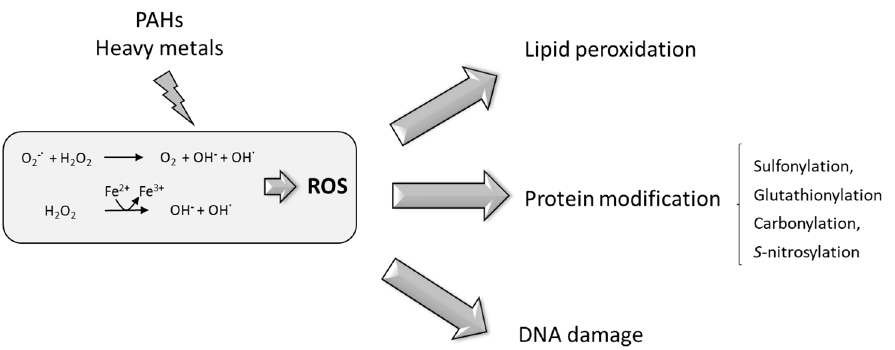
Figure 4. Schematic representation depicting the Haber-Weiss and Fenton reactions leading to ROS and its effects on lipids, proteins and DNA.